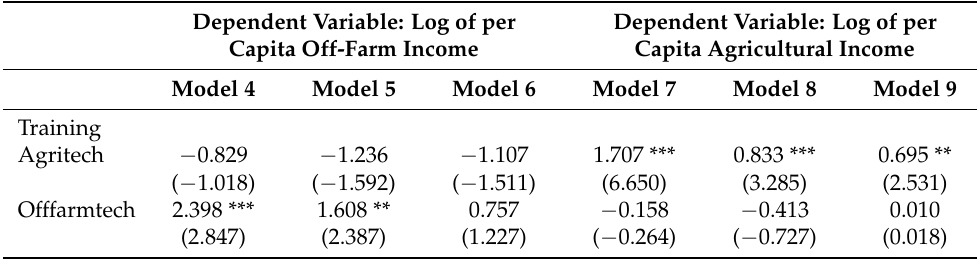
Table 5. The impacts of two different types of skill training on household off-farm and agricultural